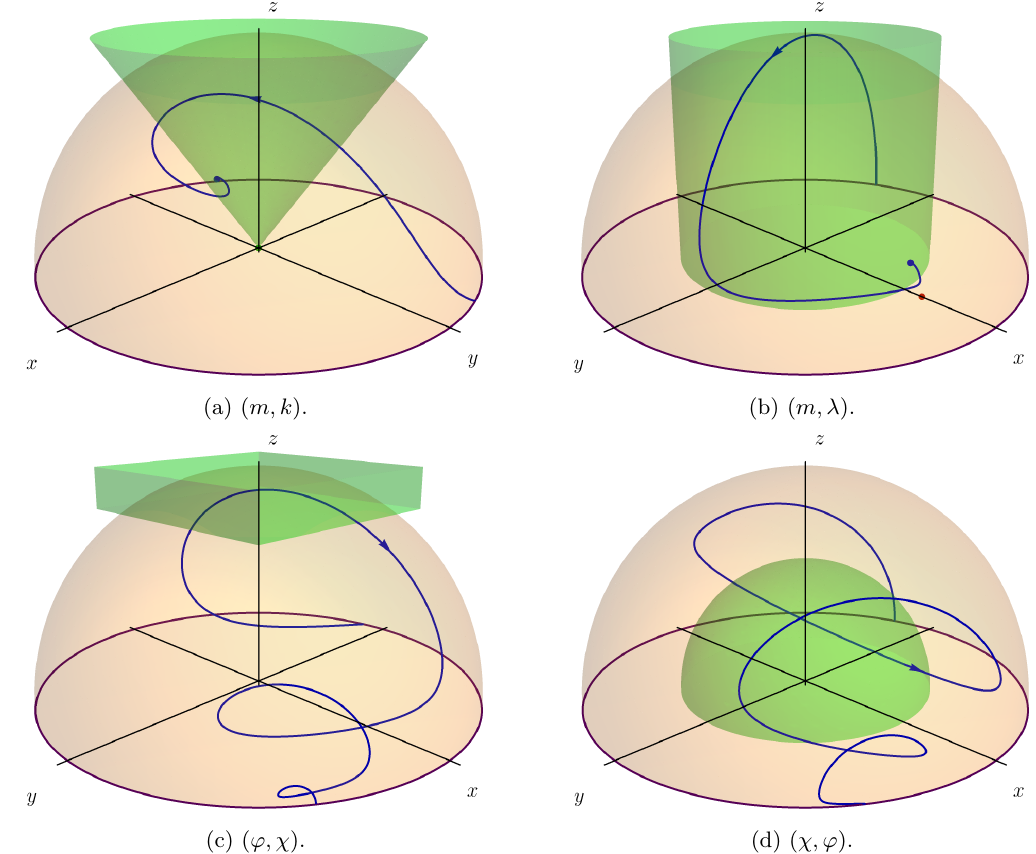
Figure 1 . Trajectories in phase space corresponding to two-flux cosmological solutions with accelerated expansion. The corresponding dynamical systems are given in sections 6.2, 6.3, 6.4. The pair of fluxes that are turned on in each case is indicated below each subfigure. The trajectories (blue lines) interpolate between a fixed point on the equator in the past infinity, corresponding to a cosmology with a power-law scale factor S ∼ T 1 , and another fixed point at future infinity. For 3 cases 1c and 1d the second fixed point is also on the equator, and thus the solution asymptotes the same scaling cosmology in the past and future infinities. Cases 1a and 1b asymptote at future infinity a fixed point in the interior of the sphere which corresponds to a cosmology with a power-law scale factor S ∼ T and S ∼ T 19 respectively. Cases 1c and 1d describe the same system, but employ 25 different parametrizations which interchange the role of the two fluxes that are turned on. The transient accelerated expansion corresponds to the portion of the trajectory within the acceleration region depicted in